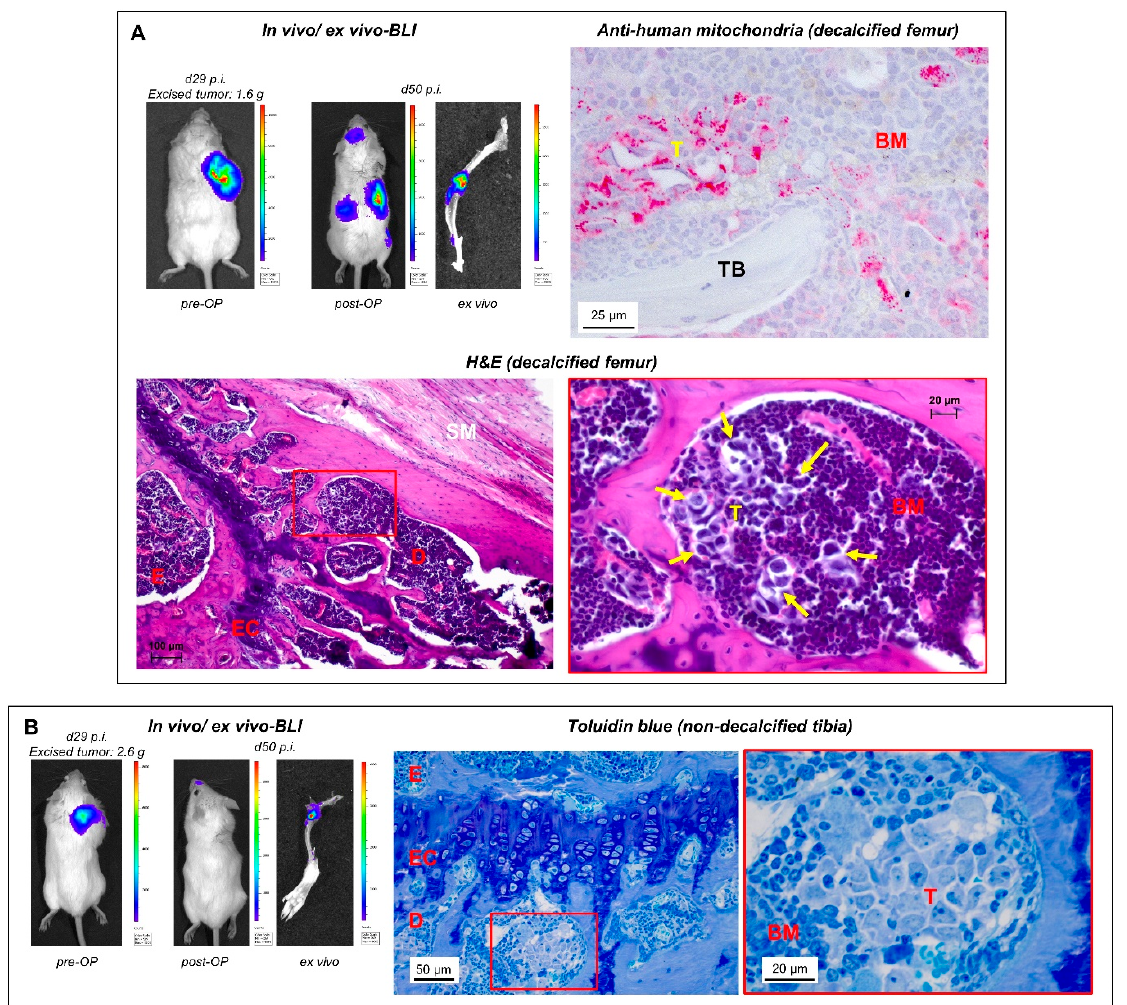
Figure 3. Ex vivo BLI is useful to detect small metastatic colonies. ( A , B ) In a human neuroblastoma xenograft mouse model (LAN-1- Luc2 / mCherry cells), early BM colonies became apparent 50 days after tumor cell injection (21 days after resection of the xenograft tumor) by ex vivo BLI (despite missing bone-related BLI signals in vivo). TB = trabecular bone; for further abbreviations, please see legend to Figure 2.